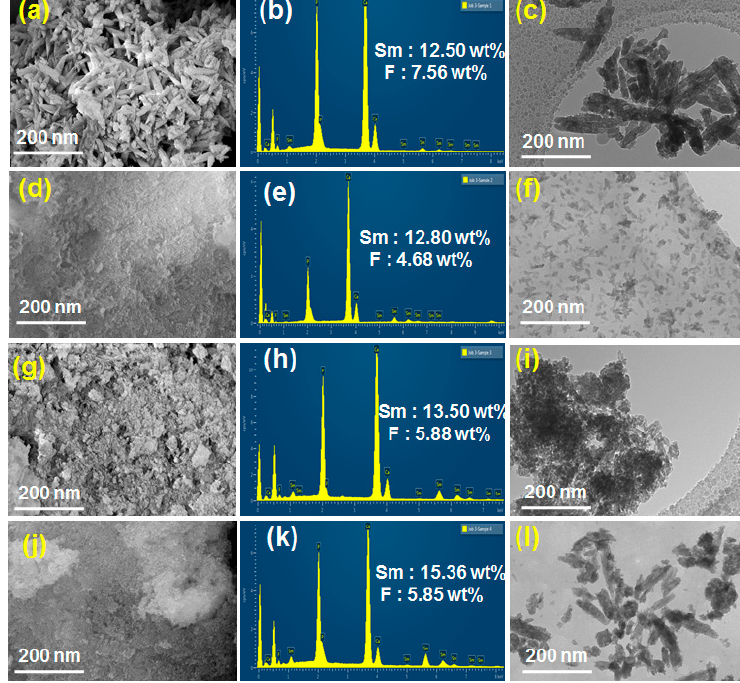
Figure 3. FE-SEM, HR-TEM micrographs and EDX spectra of ( a – c ) Sm-FAp/Glutamic acid; ( d – f ) FE-SEM, HR-TEM micrographs and EDX spectra of ( a – c ) Sm-FAp/Glutamic Sm-FAp/Aspartic acid; ( g – i ) Sm-FAp/Glycine; ( j – l ) Sm-FAp/Histidine.